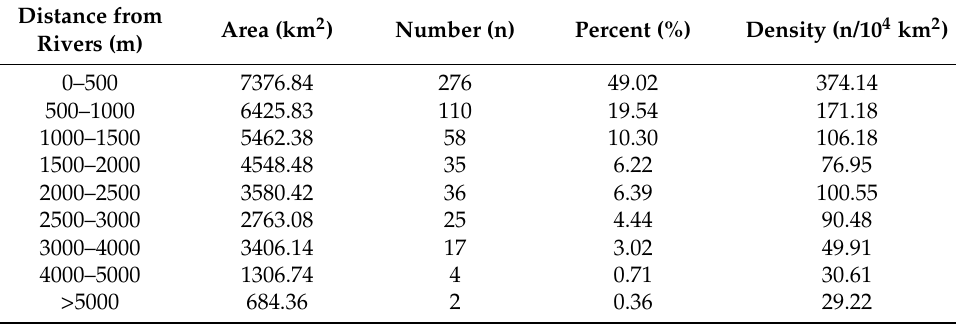
Table 3. Relationship table of settlement distribution and distance from river.